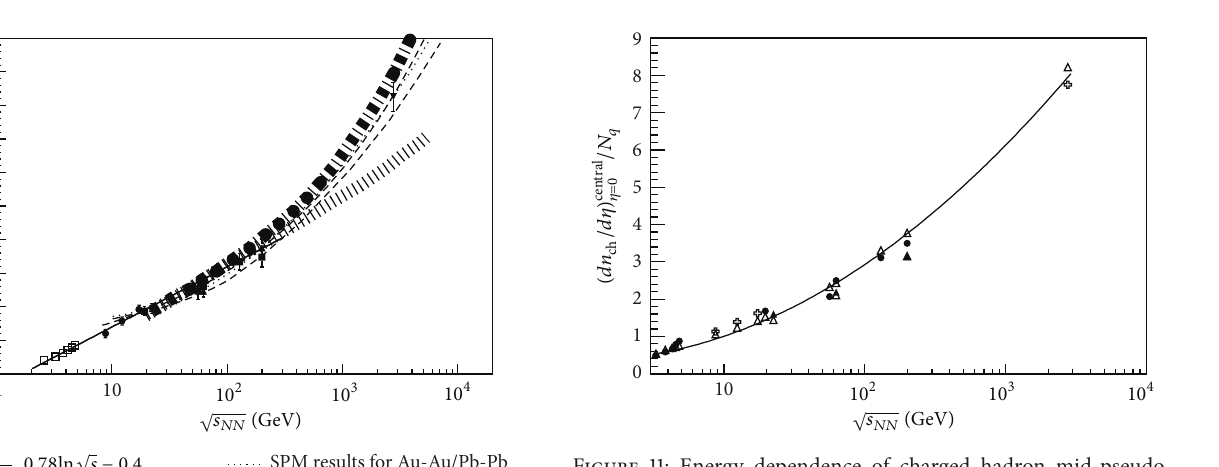
Figure 11: Energy dependence of charged hadron mid-pseudo- rapidity density per participating quark. Open triangles are wounded quark model results. Solid line is energy-dependent functional form of wounded quark model